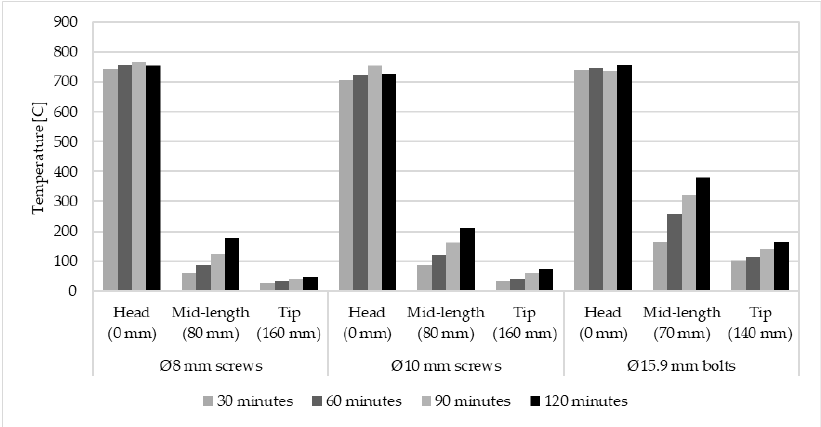
Figure 8. Distribution of temperatures on unprotected fastener heads under a constant heat flux. Hofmann et al. [18] and Owusu [38] have also evaluated the temperature distribution for STS and bolts under one hour and 30 min of standard fire exposure, respectively. Values of 60 °C and 100 °C were obtained at the mid-length of Ø 6 mm and Ø 12 mm STS under one hour of standard fire exposure in Hofmann et al. [18]. On the other hand, values around of 100 °C, 200 °C and 310 °C were obtained at the mid-length of Ø 19 mm top bolts under 10 minutes, 20 min, and 30 min of standard fire exposure in Owusu [38], respectively. As ex- pected, the thermal capacity of the shank diameter has greatly influenced the temperature distribution of the fastener with higher temperatures for bolt-type diameters than screw- type diameters, while smaller values were recorded for the Ø 6 mm screws than the corre- sponding temperatures of Ø 12 mm screws. Compared to the tested fasteners with the meas- ured temperature in our study, this effect is also confirmed by the increases of temperature distribution with increasing diameter of the fastener (i.e., Ø 6 mm < Ø 8 mm < Ø 10 mm < Ø 12 mm for STS). However, compared with the bolt-type fasteners, the screw-type fasteners lead to much lower temperatures along the shank. Although the work of Hofmann et al. [18] and Owusu [38] are limited to shorter fire exposure than in this paper, the results from both researches are consistent with the average temperature profiles obtained herein at a similar time exposure. Therefore, the results support the assumption that the heating rate through the fastener shank is proportional to the amount of exposed area and thereby contributes to local charring of the timber surrounding the steel elements. 3.2. Effect of Fasteners on the Timber Charring Rate The average values of the charring depth and rate for all the tests were measured and are presented in Table 3. The length of localized charring along the fastener’s shank is also presented. Table 3. Average values of charring depth and charring rate for all the tests exposed to a constant heat flux. Time Exposure Fasteners